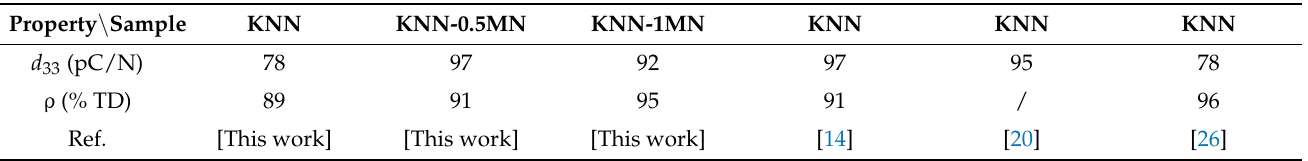
Table 1. Room temperature piezoelectric properties of KNN-xMN ceramics and a comparison with those of KNN reported in the current literature and prepared through mechanochemical activation